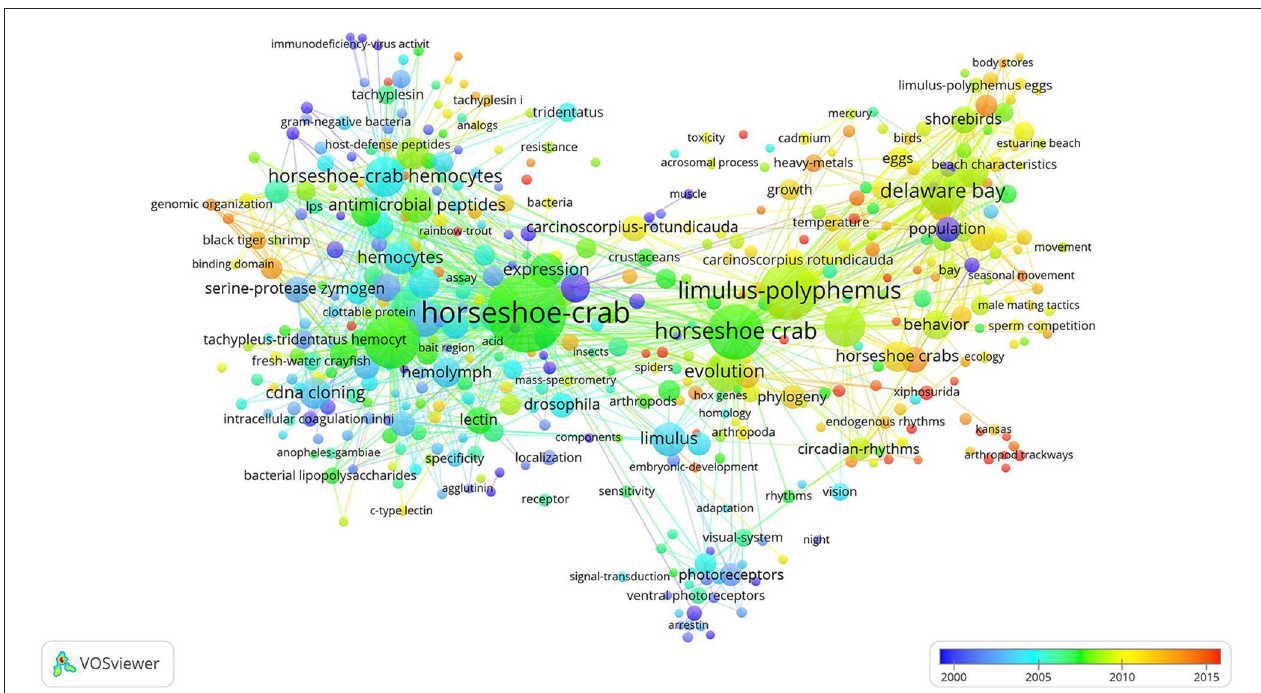
FIGURE 5 | Network showing co-occurrence among keywords. Large dots indicate a high number of publications containing a specific keyword. The color of each dot represents when the publication is released. Thick lines indicate the co-occurrence of a high number of keywords.